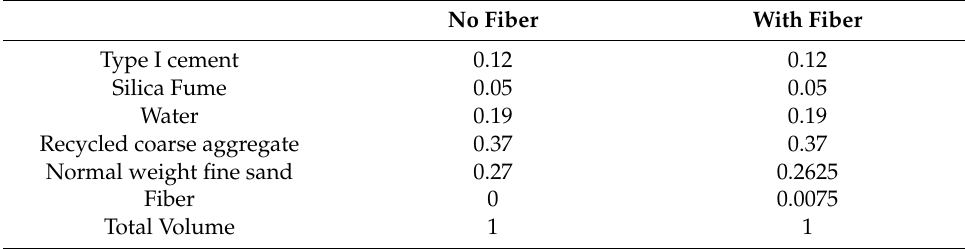
Table 5. Mix proportioning.